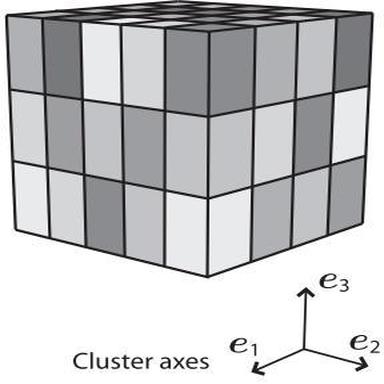
Example of a 4 5 3 × × cluster considered by the Relaxed Grain Cluster (RGC) scheme. The different gray shades indicate different crystallographic orientations and/or phases of the constituents ("grains"). Figure adopted from with permission from John Wiley and Sons.